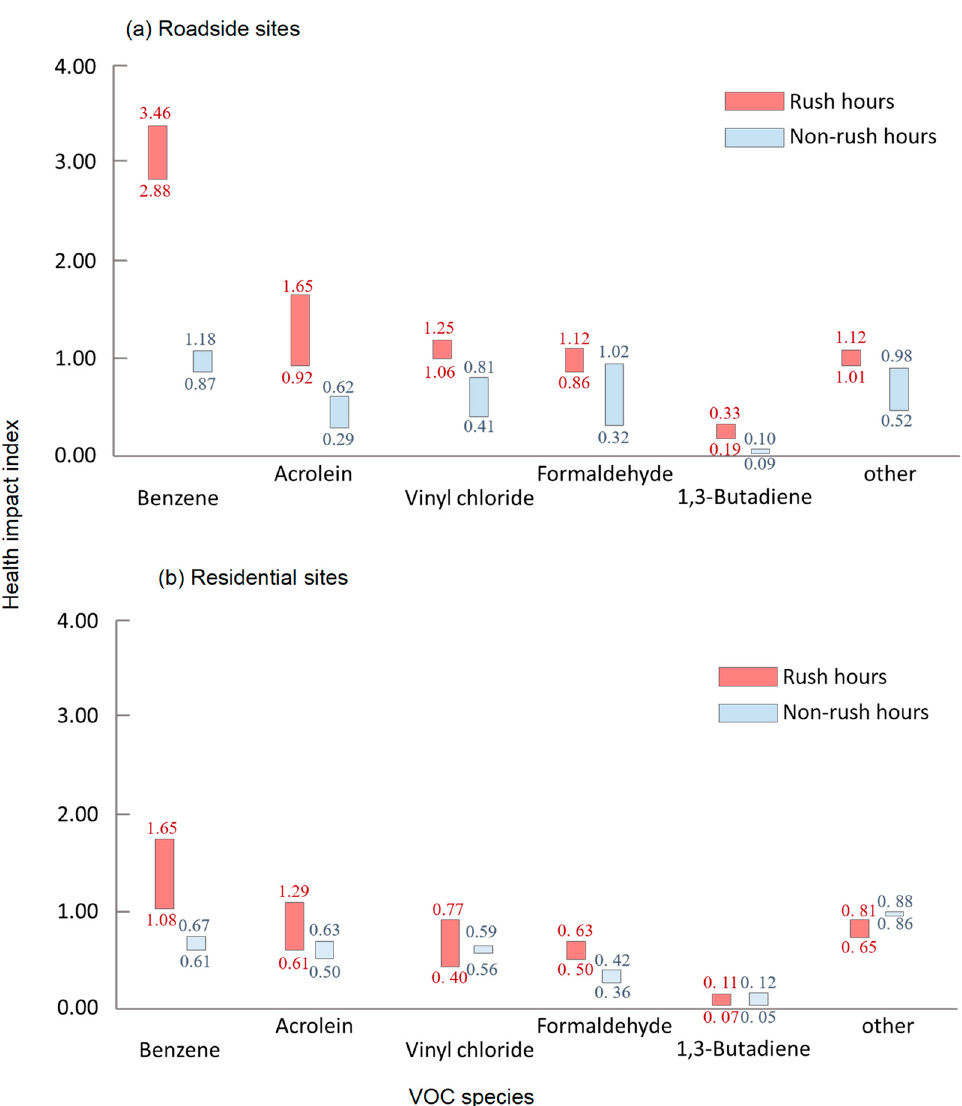
Figure 6. Health impacts of VOC species at roadside and residential sites for different sampling periods. ( a ) Roadsite sites, ( b ) Residential